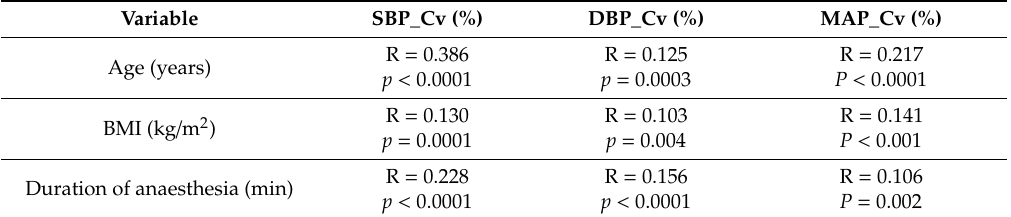
Table 3. Correlations between BPV_Cv and quantitative data 3